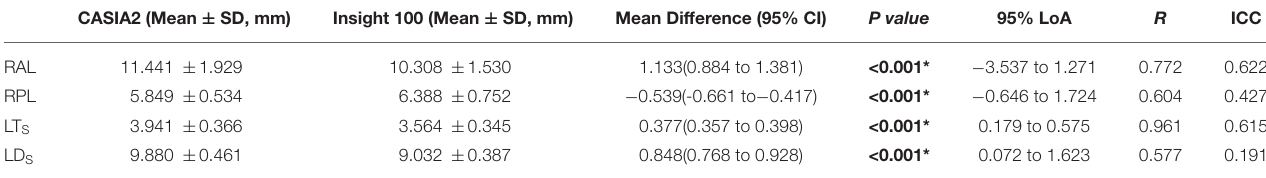
TABLE 2 | Comparison of lens biometry measured with CASIA2 and Insight